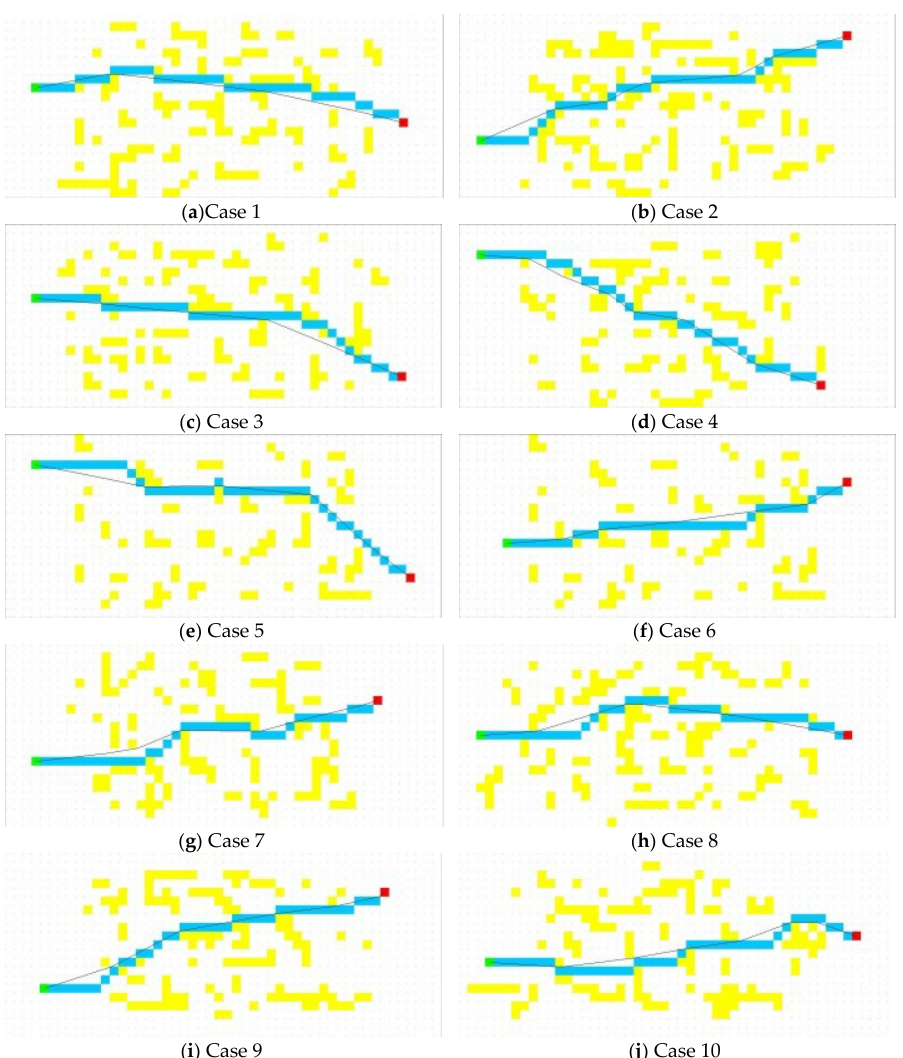
Figure 2. Path planning for random obstacle maps.